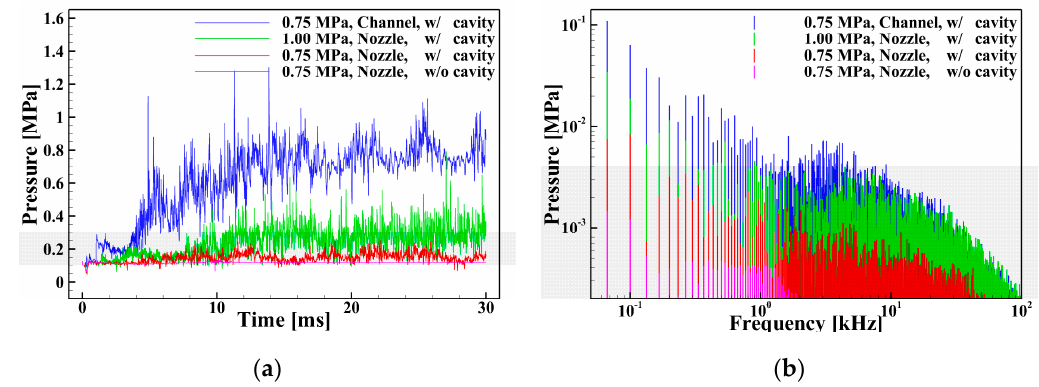
Figure 5. Results for a point at 59 cm on the lower wall surface: ( a ) pressure history and ( b ) FFT results for pressure